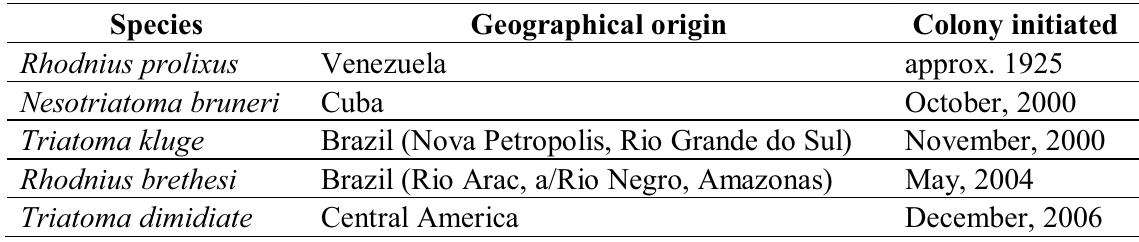
Table 1. The geographical origin of the colonies from which representative male and female adults were obtained and the date the colony was